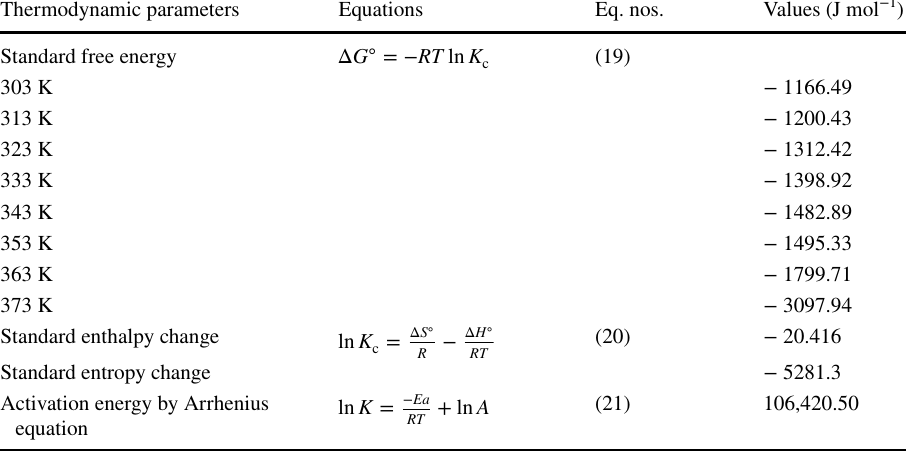
Table 4 Thermodynamic parameters of glyphosate adsorption by